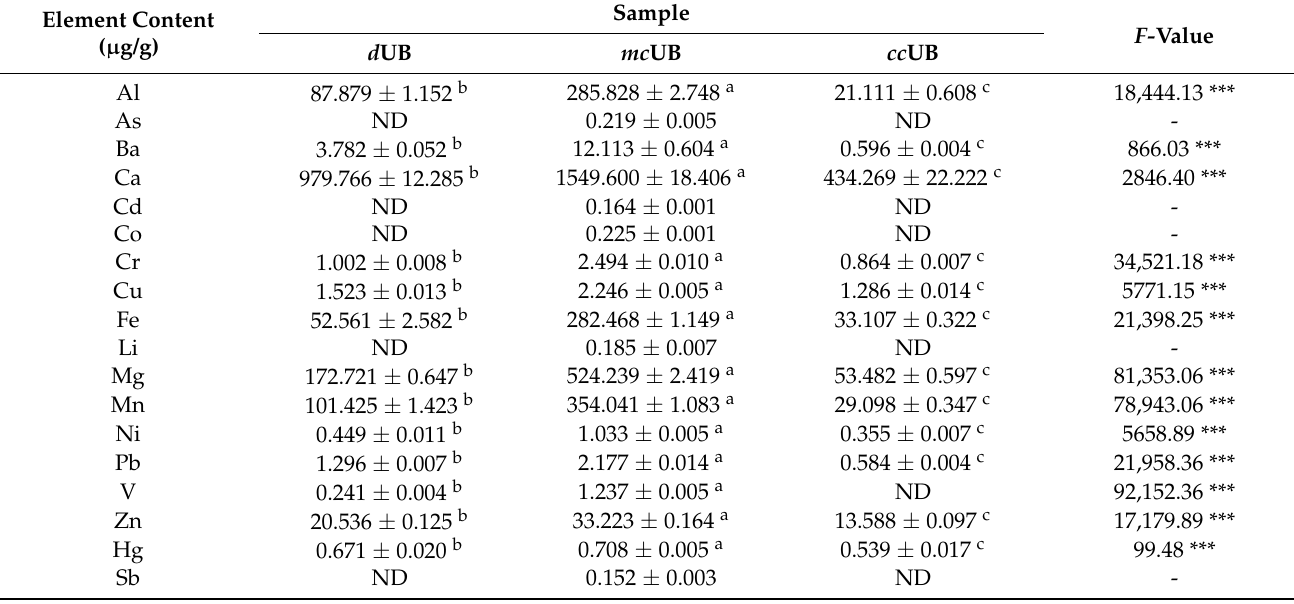
Table 2. Mineral composition of Usnea barbata (L.) Weber ex F.H. Wigg dried lichen ( d UB) and